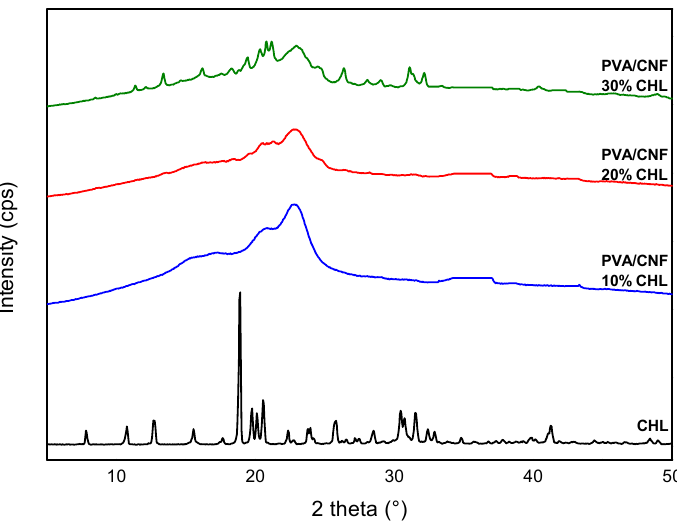
Figure 6. X-ray diffractograms of the prepared poly(vinyl alcohol) (PVA)/cellulose nanofibrils (CNF)/chloramphenicol (CHL) sponges with different CHL ratios, compared with CHL. Table 1. Hydrations on dry sample basis, for the samples as received at ambient humidity, h d,amb , and subjected to various relative humidities, h d,rhi . ( i = 2–98%).